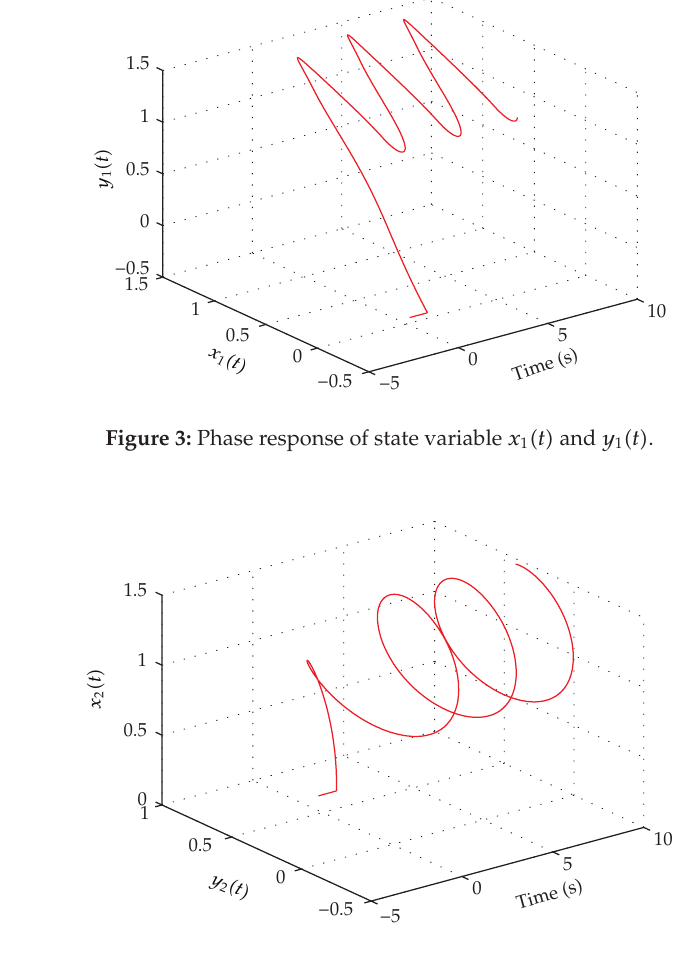
Figure 4: Phase response of state variable x 2 (cid:6) t (cid:7) and y 2 (cid:6) t (cid:7)